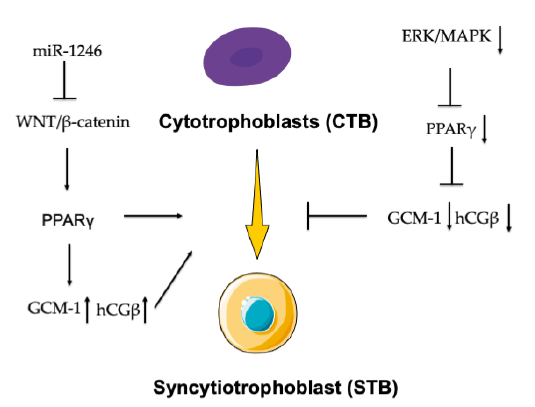
Figure 3. PPAR γ involved in trophoblast differentiation. The activation of PPAR γ increased the expression of chorionic gonadotropin beta-subunit (hCG β ) and chorion-specific transcription factor (GCM-1), which promoted cytotrophoblast (CTB) differentiation into the STB. miR-1246 promoted STB differentiation through inhibiting the WNT/ β -catenin signaling pathway and increasing the expression of the crucial transcription factor PPAR γ . The loss of the ERK/MAPK cascade caused the reduced expression of PPAR γ , affected the expression of GCM1, and inhibited the process of CTB differentiation into the STB.